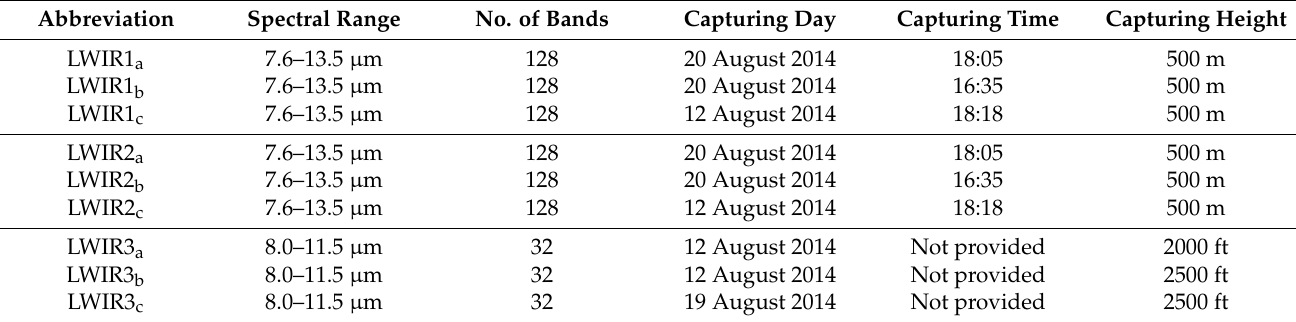
Table 3. Abbreviations and other characteristics of the selected hyperspectral data set for the registration